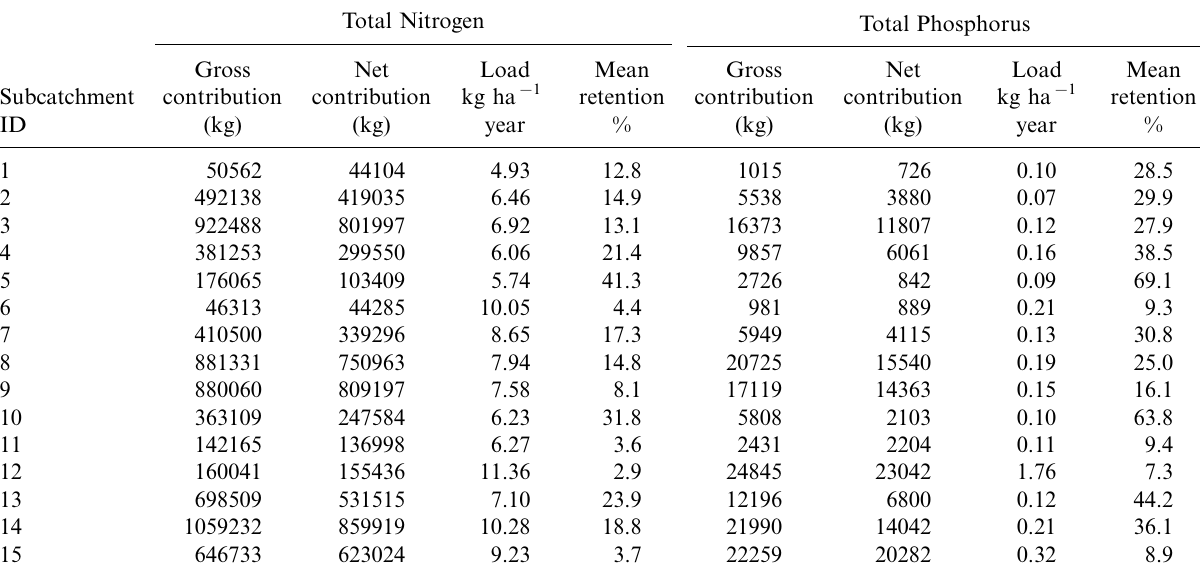
Table 3. Pollution load and retention in Be¯rze River subcatchments (2000 (cid:2)